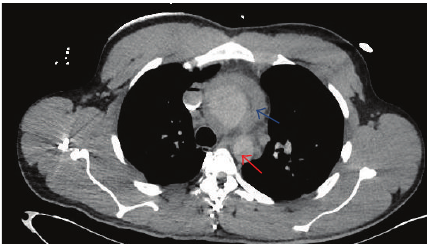
Figure 4: CT chest: ascending aortic dissection (red arrow) and hemopericardium (blue